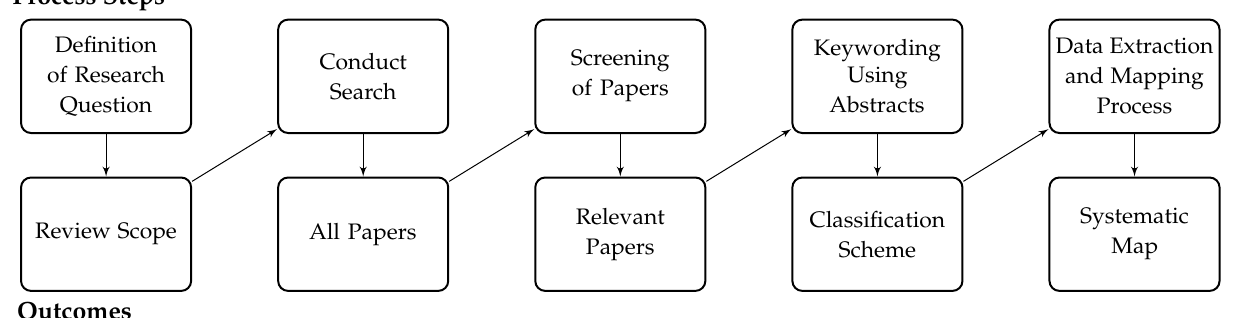
Figure 1. Process steps and outcomes proposed by